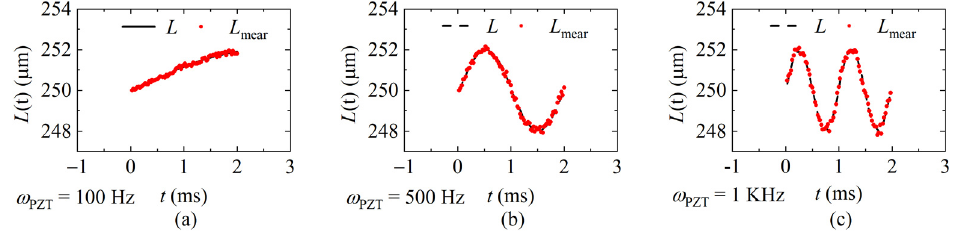
Figure 13. The demodulated distance at the sweeping rate of 40 KHz. ( a ) ω PZT = 100 Hz ( v max = 0.001 m/s); ( b ) ω PZT = 500 Hz ( v max = 0.006 m/s); ( c ) ω PZT = 1 KHz ( v max = 0.01 m/s).